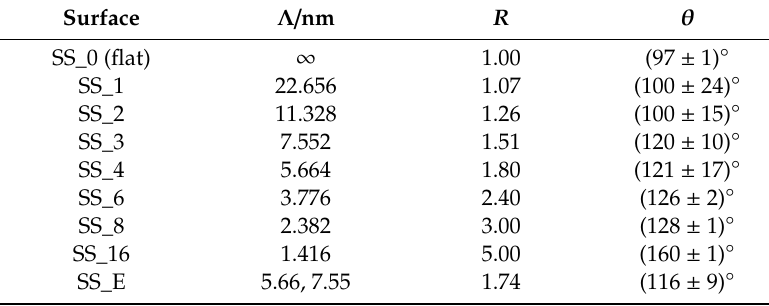
Table 1. Roughness factor R and measured contact angle (°) of the model surfaces. SS_0 to SS_16 represent surfaces having 0 to 16 sinusoidal waves ( c.f. Figure 3). SS_E represents the surface reproducing the Ketton topography (Figure 2b).